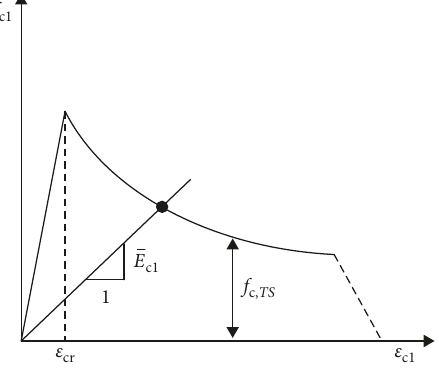
Figure 7: Concrete tension stiffening behavior.